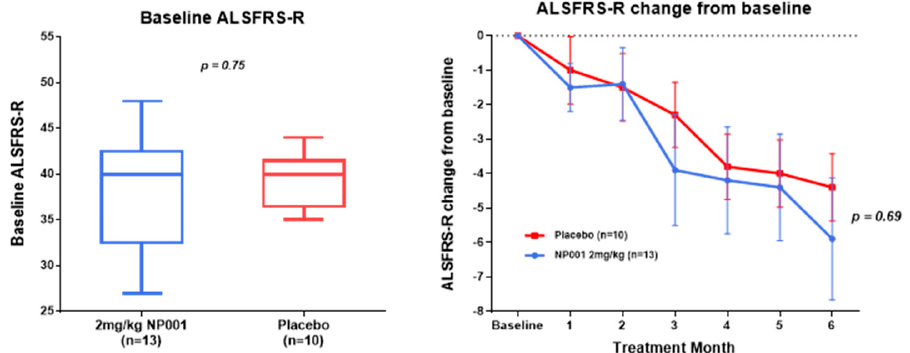
Figure 2. Comparison of baseline ALSFRS-R score and ALSFRS-R score change from baseline over the six-month study in participants treated with NP001 compared to placebo in those with plasma CRP < 1.13 mg/L at baseline. A comparison of baseline ALSFRS-R scores is on the left side. No statistically significant differences were found between NP001 treated and Placebo groups (Wilcoxon test, p = 0.75). ALSFRS-R score change from baseline is on the right side: ALSFRS-R score change from baseline for participants treated with NP001 depicted in blue ( n = 13) and compared to placebo group depicted in red ( n = 10). The plots represent the mean of ALSFRS-R score change from baseline ± SEM (standard error of the mean). No differences were seen be-tween NP001 and placebo groups by the end of study (Wilcoxon test, p = 0.69).